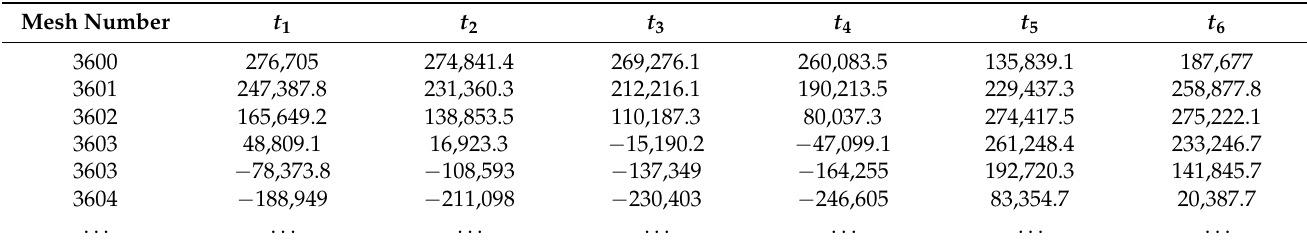
Table 3. Stress of mesh of wet surface (Pa).